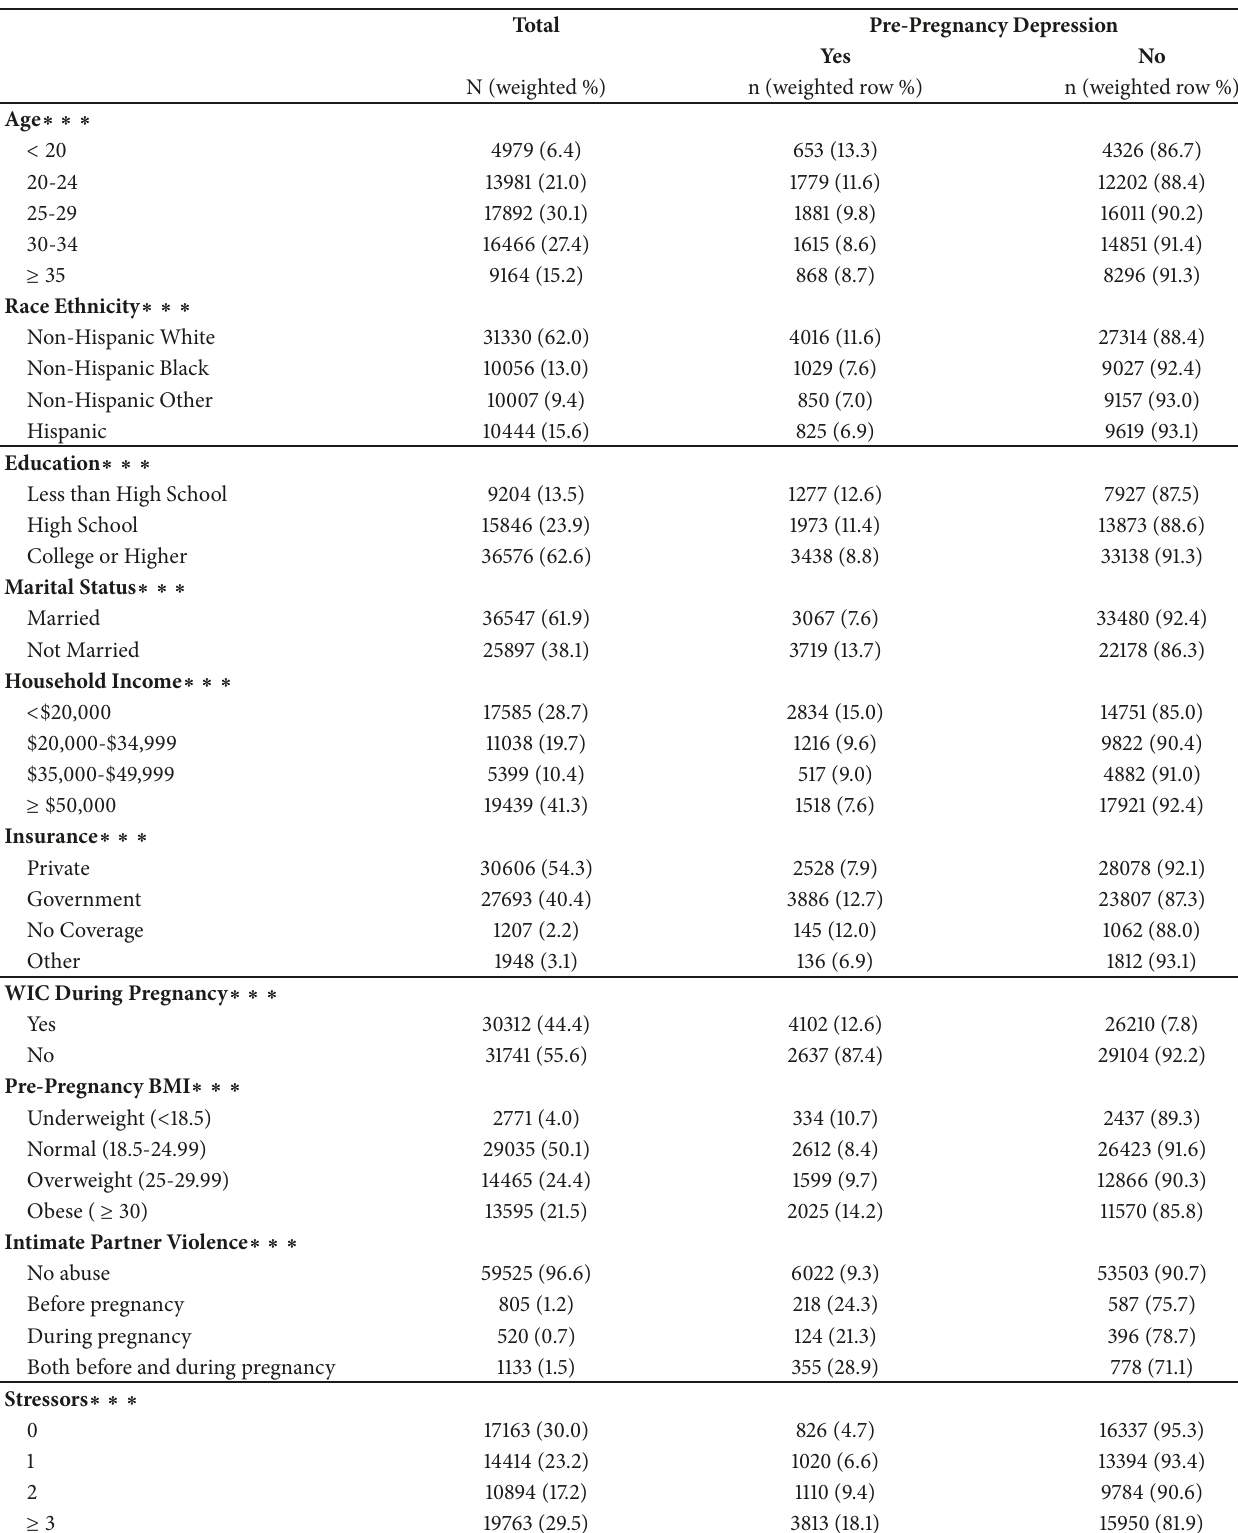
Table 1: Distribution of study population characteristics by prepregnancy depression